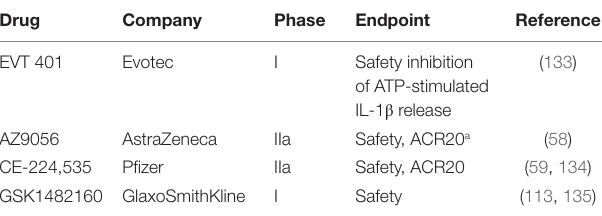
TABLe 1 | P2X7 inhibitors in clinical